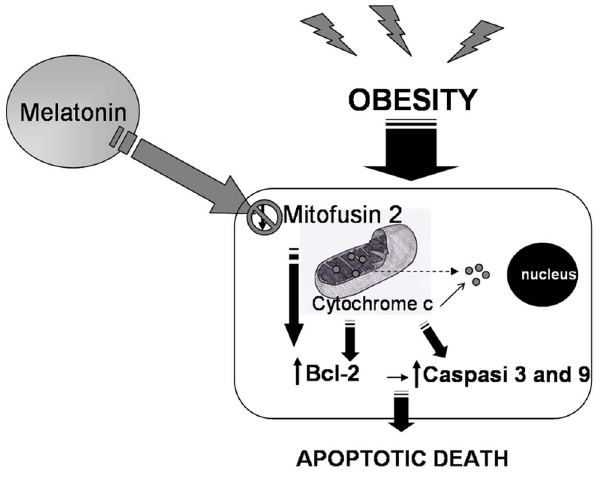
Figure 5. Melatonin remodels mitochondria in obese mice kidneys. A schematic representation of the apoptotic pathway induced by obesity mediated alterations in the kidney conditioned by upstream mitofusin 2 and the inhibiting action of melatonin on the mitochondria-driven intrinsic apoptotic cascade.